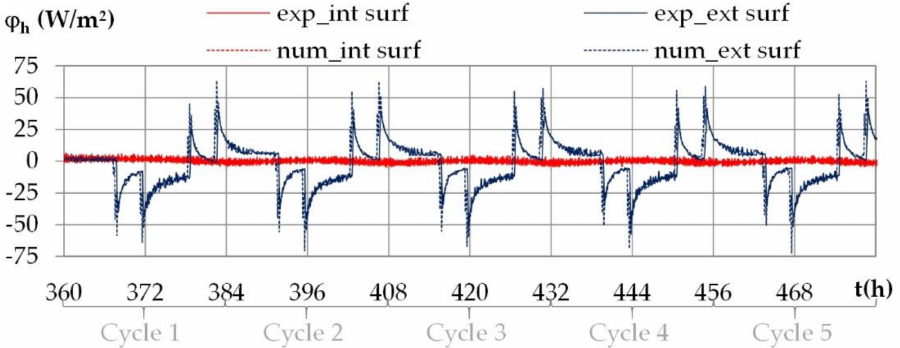
Figure 19. Experimental and numerical heat fluxes on the interior and exterior surfaces during the daily cycles for the climate of Kairouan.